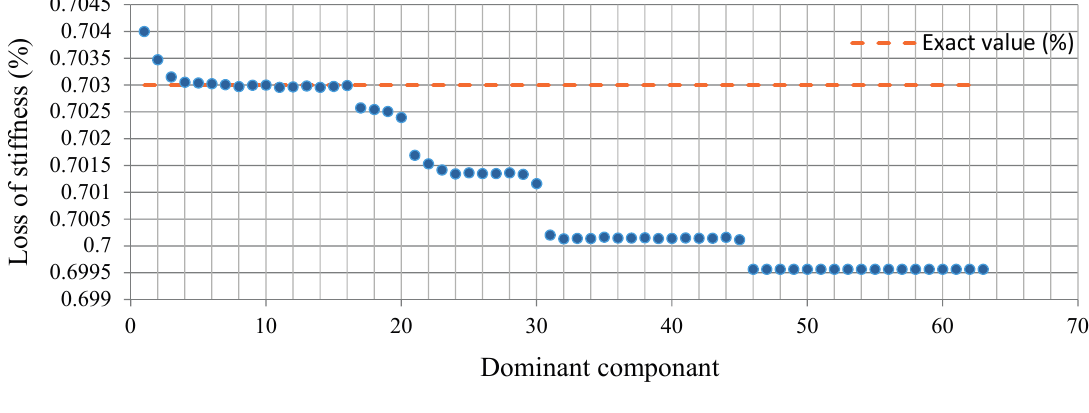
Figure 9. Loss of stiffness identification in Case